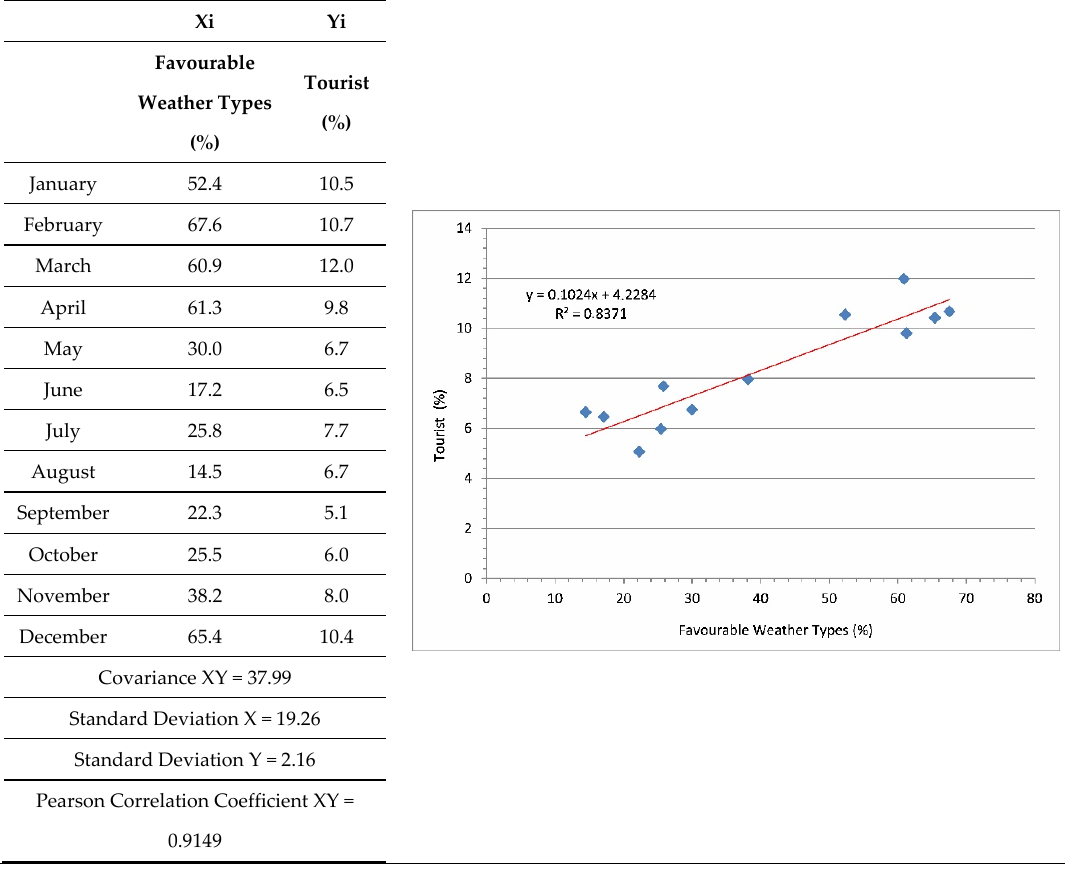
Figure 2. Monthly distribution of favourable weather types (1991–2014) and monthly distribution of tourists in Cuba (1991–2014). Source: The data series from which the monthly distribution of tourists in Cuba for the period 1991–2014 was calculated are from the Cuban Statistics Office (Oficina de Estadísticas de Cuba).